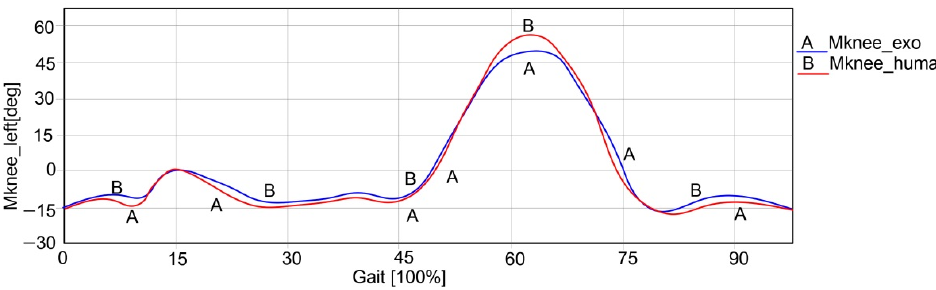
Figure 33. Left knee angular variation exoskeleton vs. human subject during a complete gait.